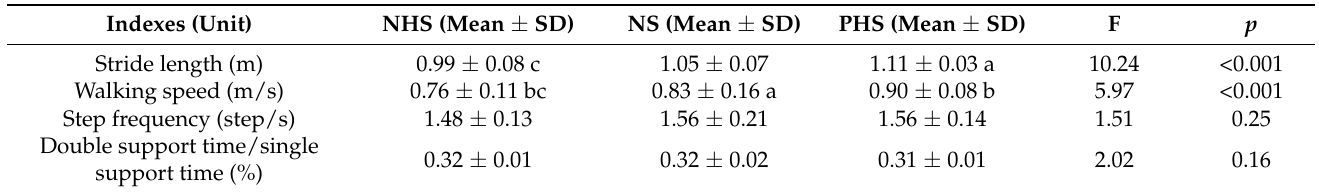
Table 2. Mean values, standard deviations, and results of the repeated measures ANOVA for spatiotemporal